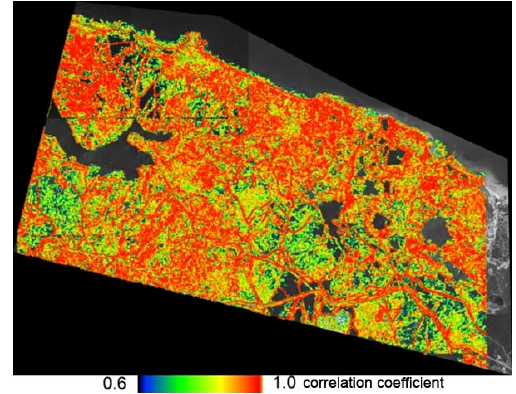
Figure 8. Distribution of correlation coefficients in WorldView- 2 model, Black Sea cost, close to Istanbul, b/h=1:1.26 With same matching method also height models have been generated with WorldView-2 images (0.5m GSD) in an area with similar roughness and forest coverage (Büyüksalih et al. Figure 6. Frequency distribution of correlation coefficients, 2012). WorldView-2 (WV-2) for the panchromatic band has a CF=centre and first image, CL=centre and last image, FL=first spectral range from 450nm to 800nm, similar to Pleiades with and last image, WV-2=WorldView-2 470nm to 830nm. The WV-2 images are taken with 69° sun elevation, this should be better as for Pleiades images